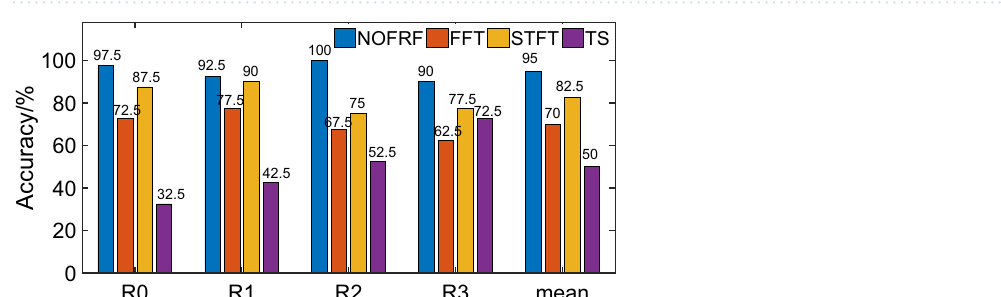
Figure 16. The NOFRF spectrum reorganize process.